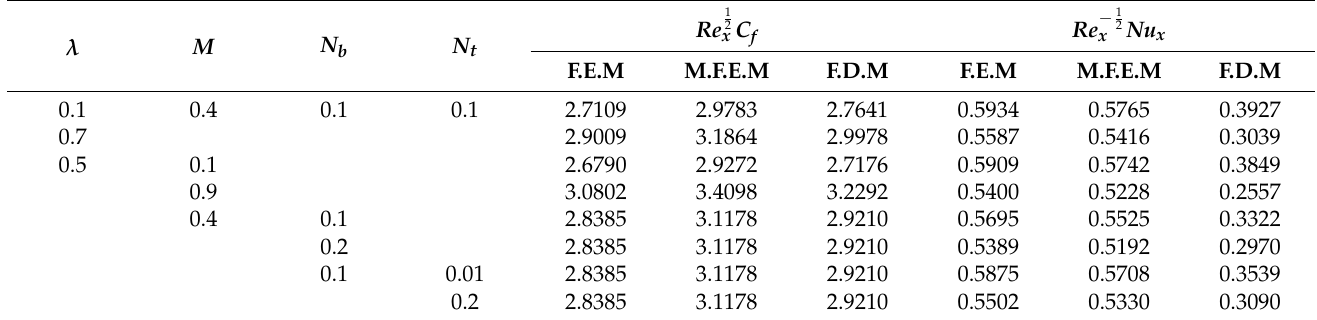
Table 3. Numerical values and comparisons of finite element methods and finite difference methods